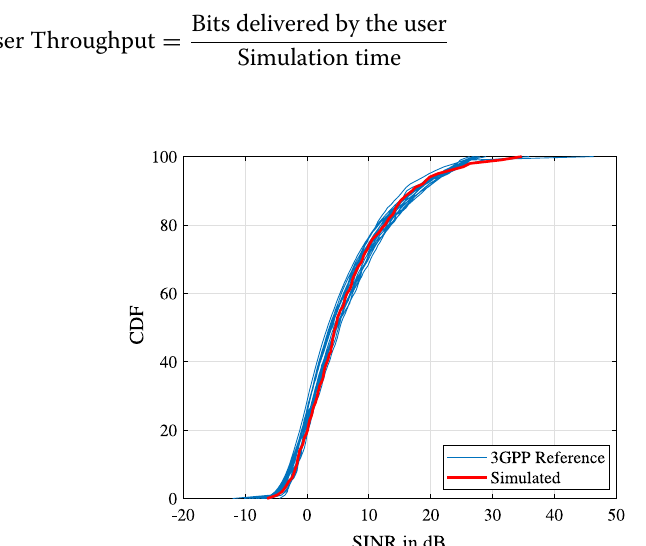
Fig. 8 Calibration of SINR with